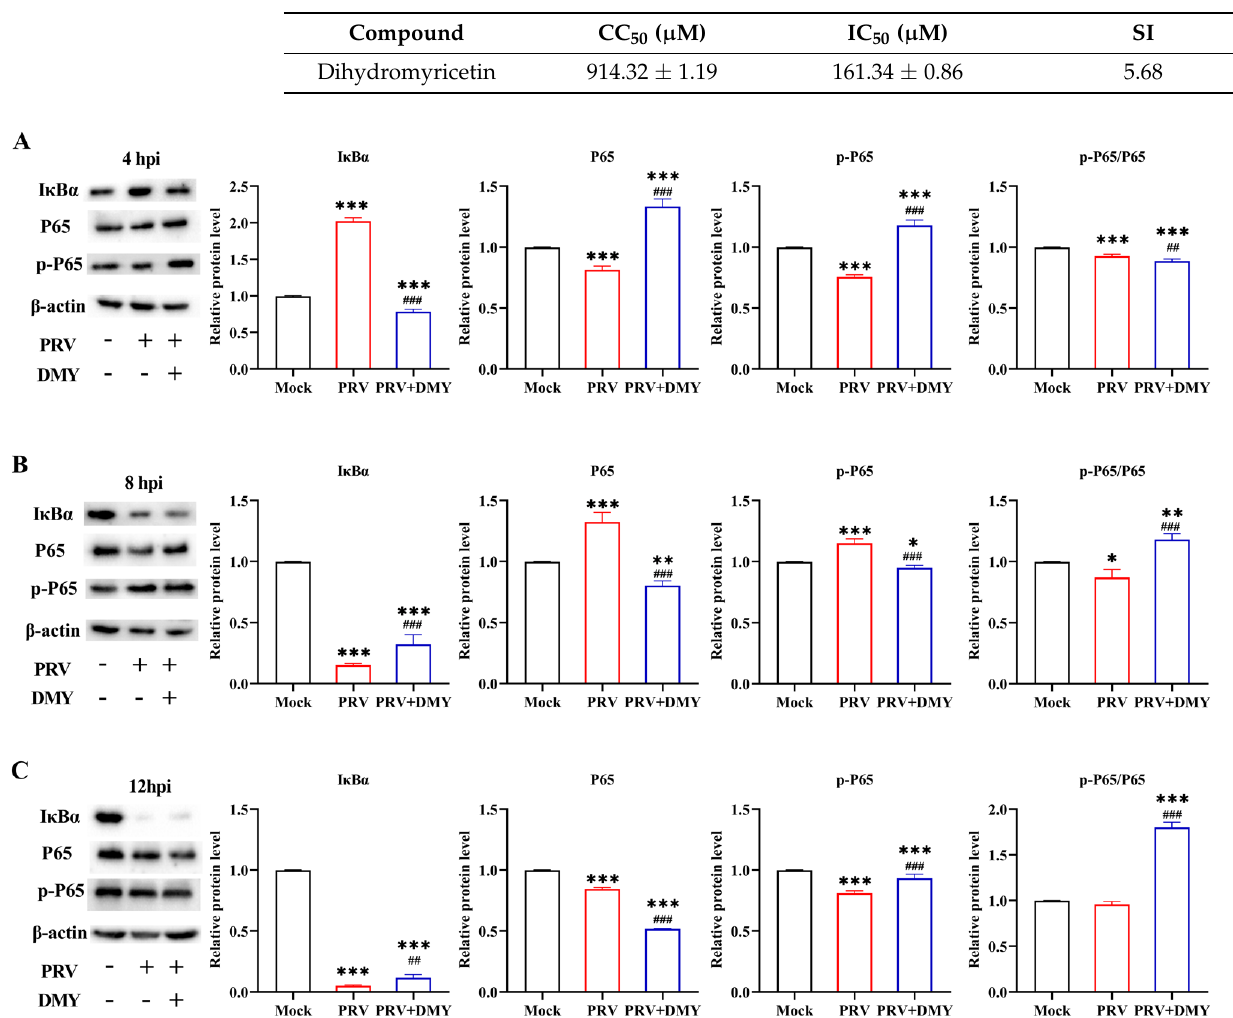
Table 2. Anti-PRV activity of dihydromyricetin.